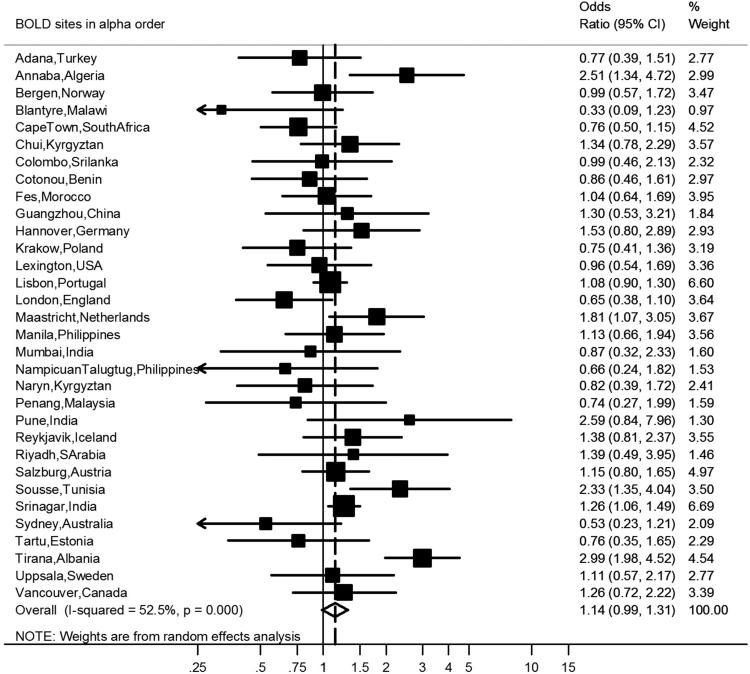
Meta-analysis of the adjusted odds ratios for hypertension in subjects with airflow obstruction. Forest plot showing the meta-analysis of odds ratios for hypertension, adjusting for age, smoking (pack-years and current smoking status), BMI, education and sex in subjects with airflow obstruction compared to those without airflow obstruction. Heterogeneity chi-squared = 65.31, d.f. = 31 (P = 0.000). I-squared (variation in ES attributable to heterogeneity) = 52.5%. Estimate of between-study variance Tau-squared = 0.0694. Test for overall effect: Z = 1.79 (P = 0.074). The following sites could not be included in the analysis due to a low number of subjects reporting hypertension: Ife (Nigeria).